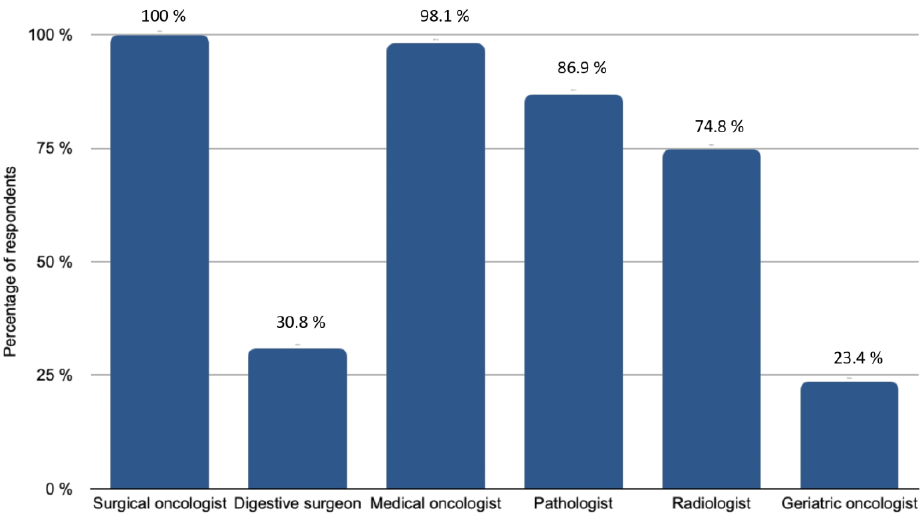
Figure 2. Medical specialities involved in tumour boards.